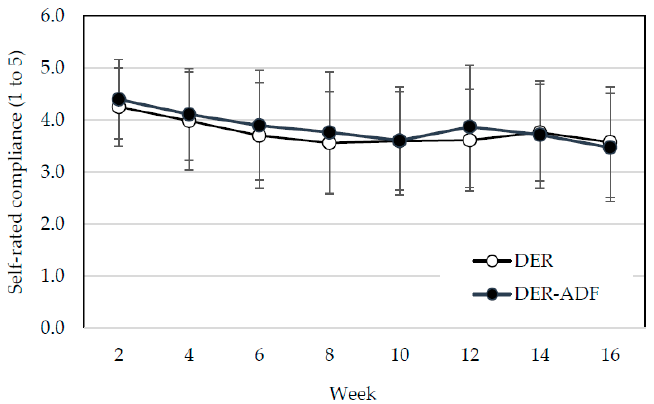
Figure 3. Self-rated compliance (out of five stars) to dietary program for DER and ADF + DER groups. DER, standard meal replacement program; ADF + DER modified meal replacement